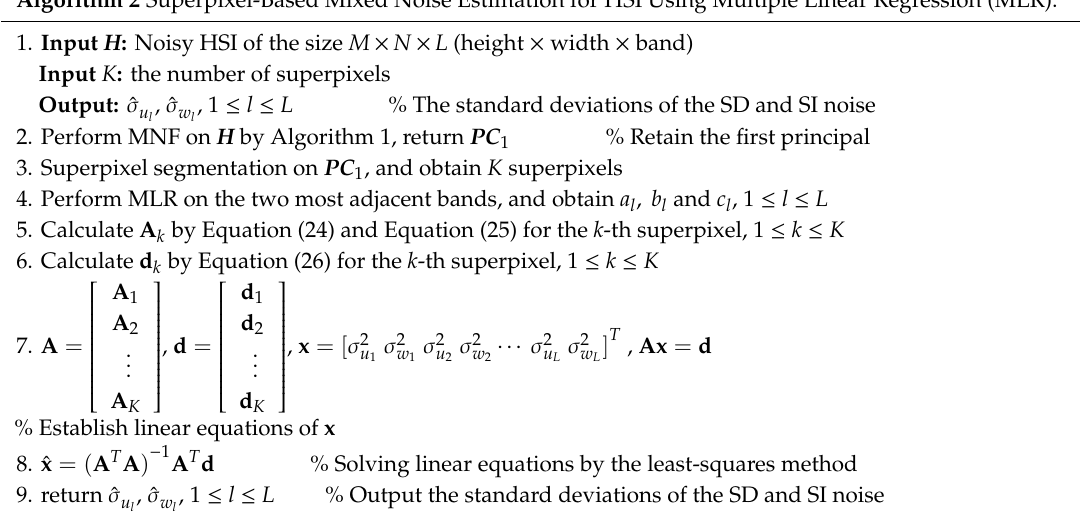
Algorithm 2 Superpixel-Based Mixed Noise Estimation for HSI Using Multiple Linear Regression